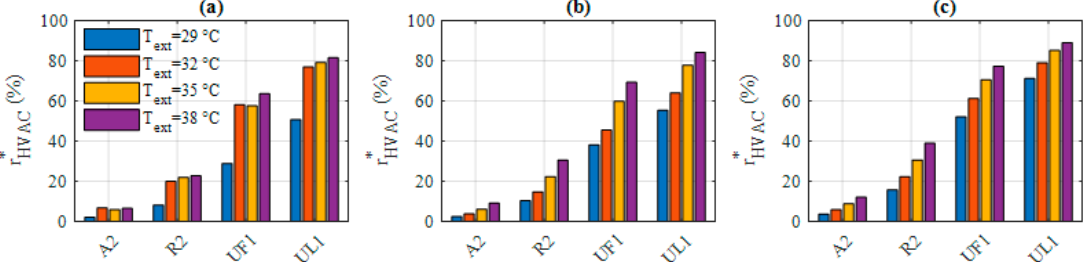
Figure 11. HVAC system consumption ratio (cid:1870) (cid:3009)(cid:3023)(cid:3002)(cid:3004)∗ for a driver dressed in an informal way, in moderate humid weather ( (cid:1844)(cid:1834) (cid:1857)(cid:1876)(cid:1872),0 = 55% ), for four (cid:1846) (cid:1857)(cid:1876)(cid:1872) ((cid:1872)) and three (cid:1869)(cid:4662) (cid:3046)(cid:3048)(cid:3041),(cid:2868) characterized by: ( a ) (cid:1869)(cid:4662) (cid:3046)(cid:3048)(cid:3041),(cid:2868) = 0(cid:1849) , ( b ) (cid:1869)(cid:4662) (cid:3046)(cid:3048)(cid:3041),(cid:2868) = 500(cid:1849) , and ( c ) (cid:1869)(cid:4662) (cid:3046)(cid:3048)(cid:3041),(cid:2868) = 1000(cid:1849) .